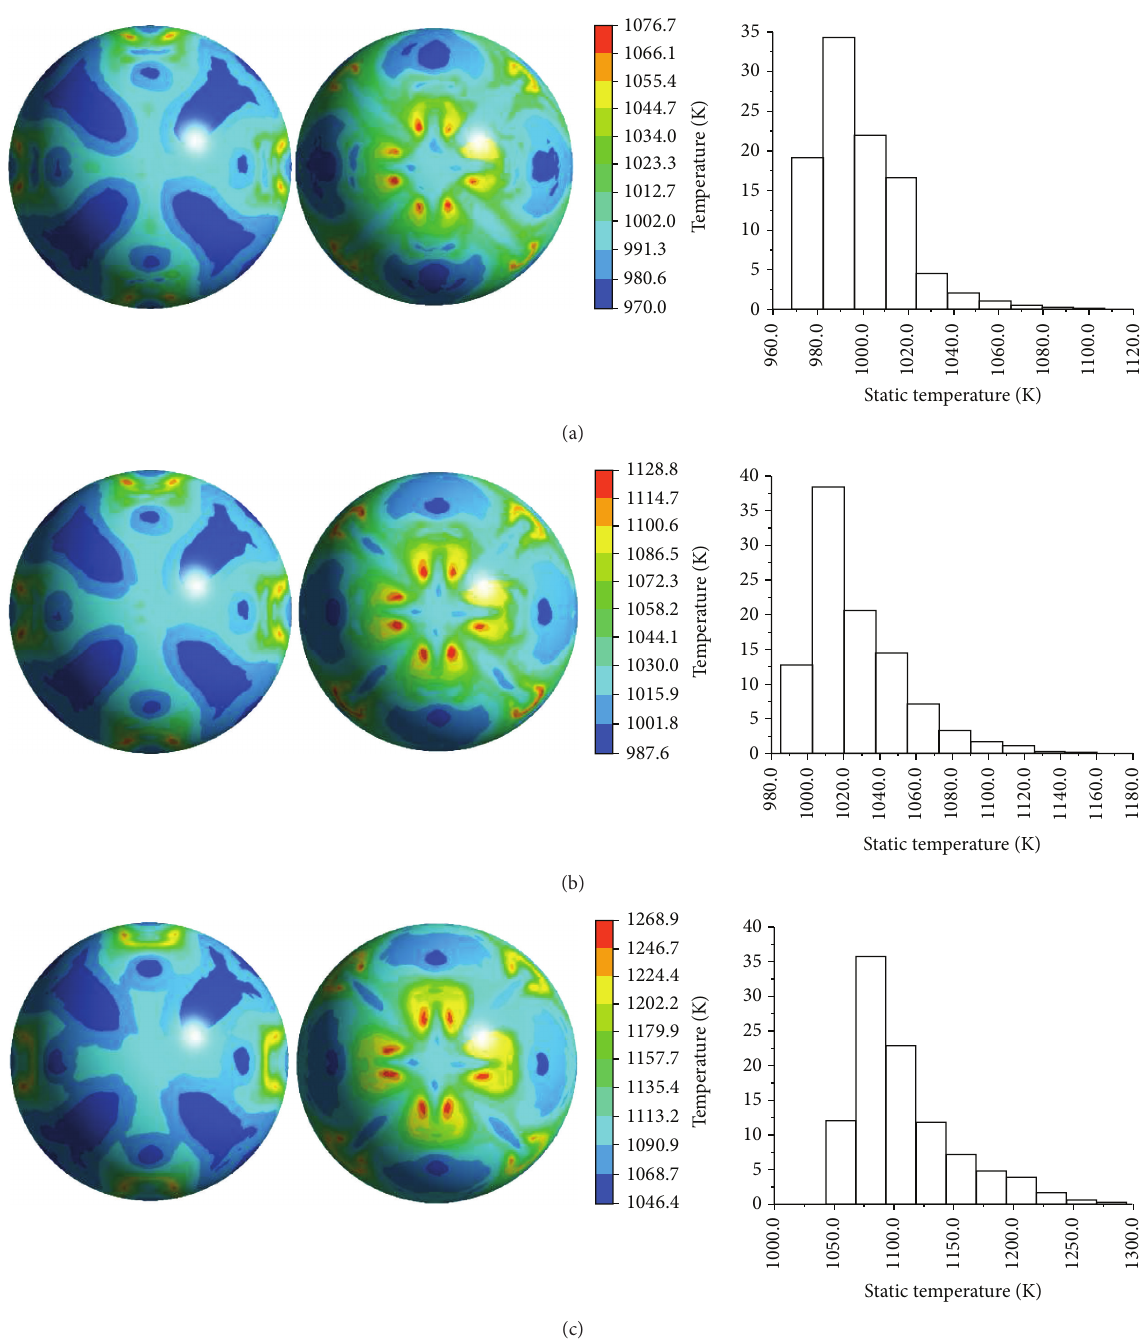
Figure 12: Pebble temperature distribution of FCC model of Cases 3a, 3b, and 3c, (view from inlet (left), outlet (middle)) and temperature distribution